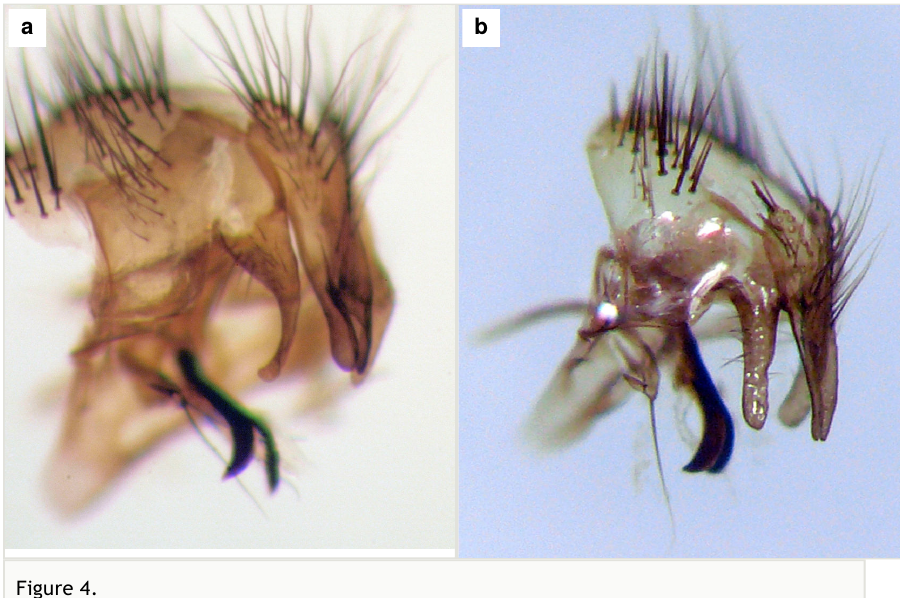
Figure 4. Male terminalia of Caiusa spp. reared from tree frog nests at Shyamkhola More (West Bengal, India), left lateral